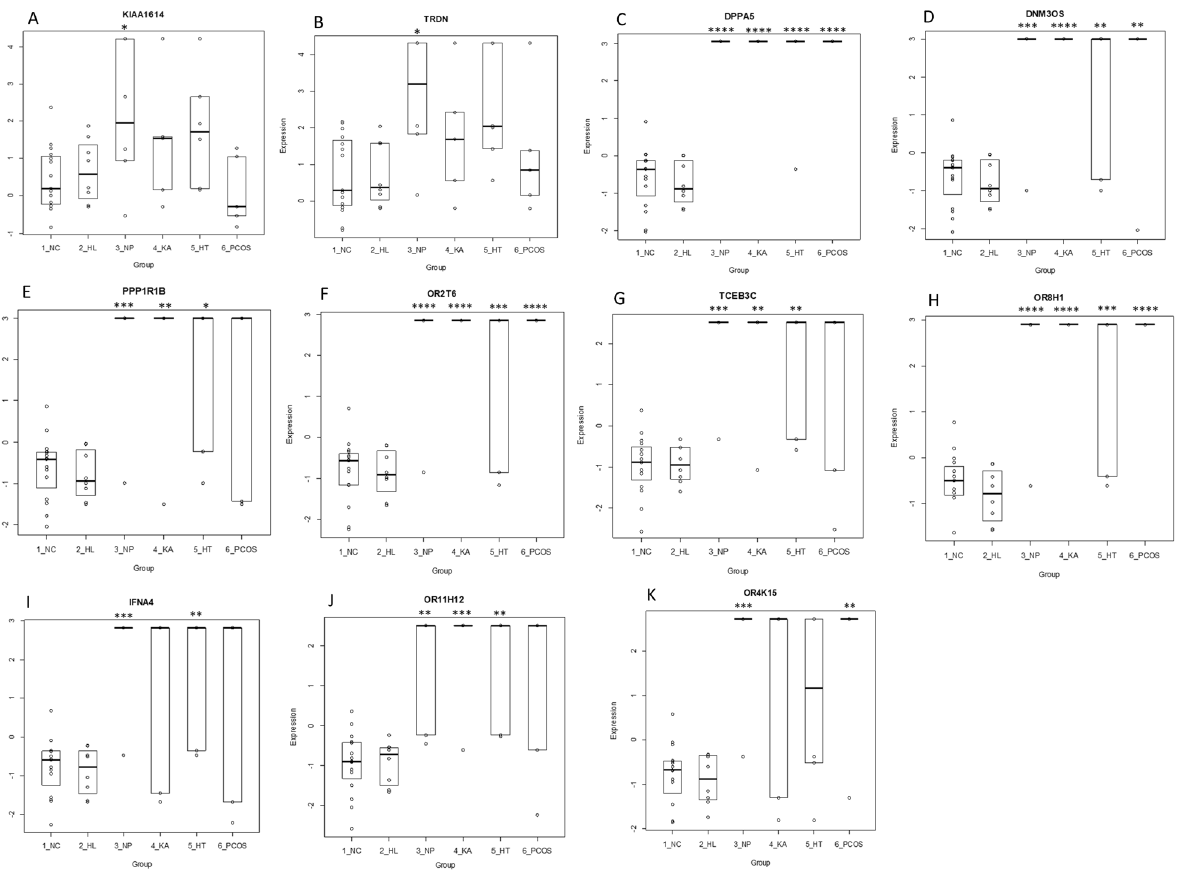
Figure 8. Boxplots of upregulated and downregulated genes differentially expressed between DWC and T1DM with complications. Fig. ( A,B ) show corresponding boxplots for the upregulated genes ( KIAA1614 , TRDN ) whereas Fig. ( C – K ) show corresponding boxplots for the downregulated genes ( DPPA5 , DNM3OS , PPP1R1B , OR2T6 , TCEB3C , OR8H1 , IFNA4 , OR11H12 , OR4K15 ). Significance was calculated using one- way ANOVA between the DWC group versus the complication groups. P < 0.05 was considered significant (*P < 0.05; **P < 0.01, ***P < 0.001, ****P < 0.0001). DWC T1DM without complication, HL Hyperlipidemia,